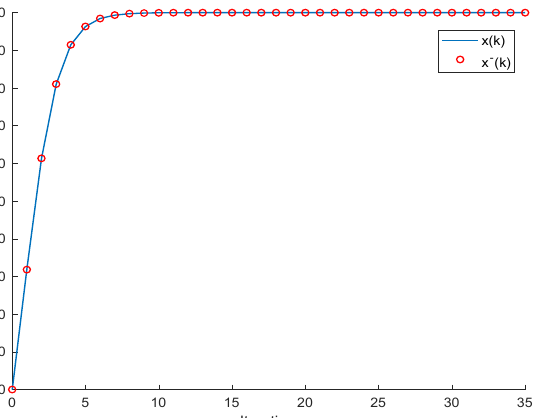
Figure 3. Evolution of x ( k ) for constant parameters in Example 3, including harvesting and external consumption. The population converges to a positive equilibrium point.